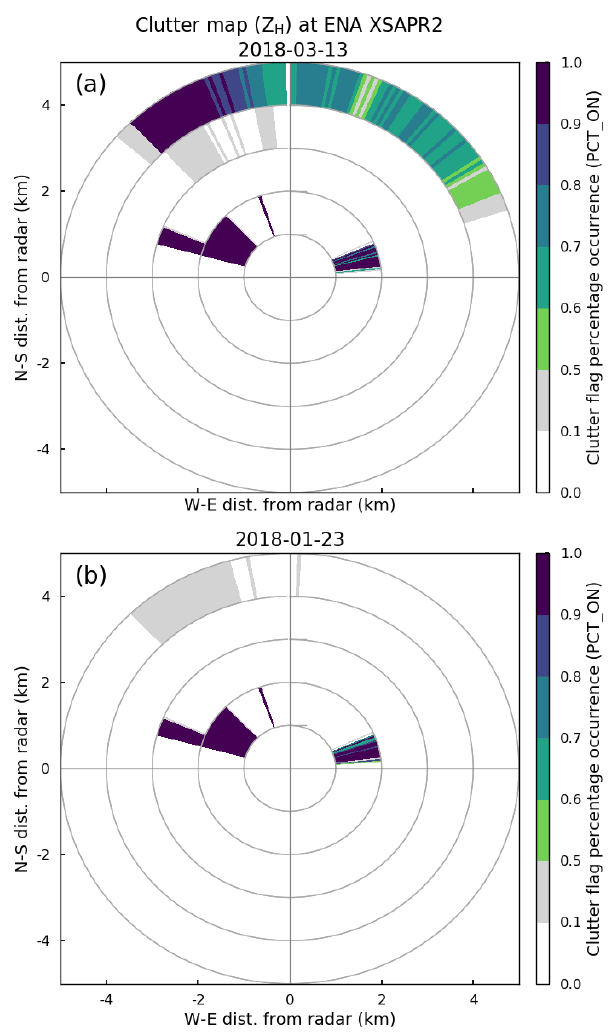
Figure 9. Daily clutter map for XSAPR2 PPIs at the ENA site for 13 March 2018 (a) and 23 January 2018 (b) . These maps show how the variability in ground clutter (primarily induced by the significant sea clutter around the site) can cause the clutter choices to change. There are, however, points in common that are stable regardless of time period used as seen to the north within 3km of the radar in both images.